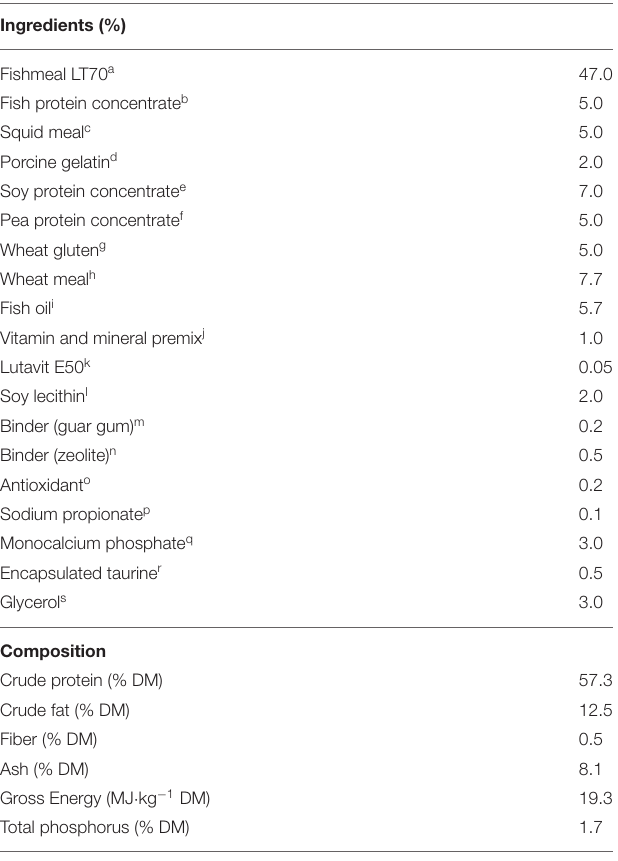
TABLE 1 | Formulation and proximate composition of experimental